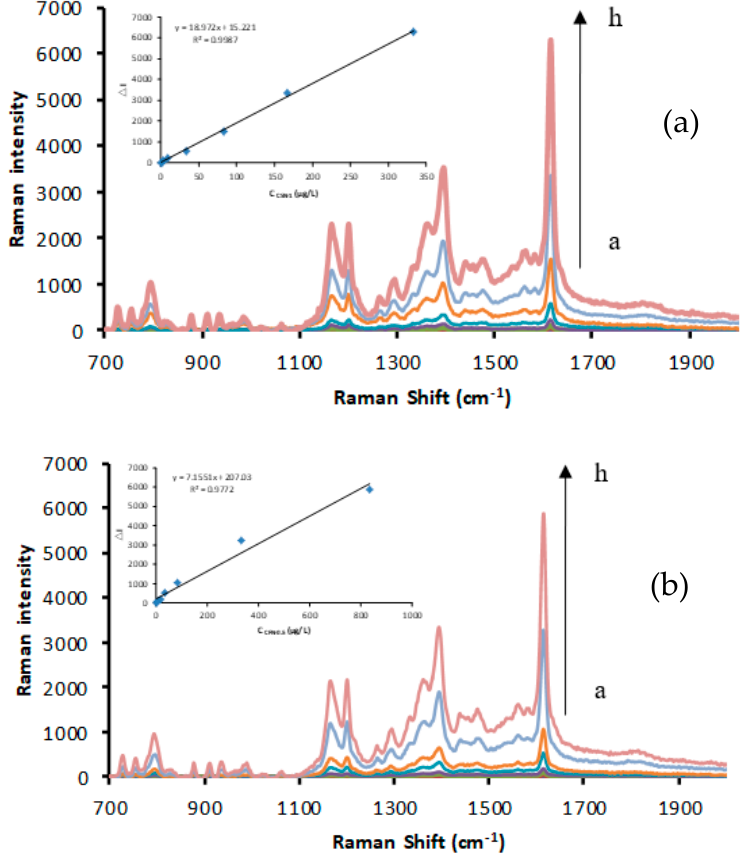
Figure 2. Surface − enhanced Raman scattering (SERS) spectra. ( a ) a to h: solutions of CD − FN3 (0, 1.67, 3.33, 8.33, 33.33, 83.33, 166.67, and 333.33 µ g/L) + 1.33 mmol/L AgNO 3 + 4.67 mmol/L TSC +3.33 × 10 − 7 mol/L Victoria blue B (VBB) + 0.02 mol/L NaCl; ( b ) a to h: solutions of CD − SN2 (0, 3.33, 8.33, 16.67, 33.33, 83.33, 333.33, and 833.33 µ g/L) + 1.33 mmol/L AgNO 3 + 4.67 mmol/L TSC +3.33 × 10 − 7 mol/L VBB + 0.02 mol/L